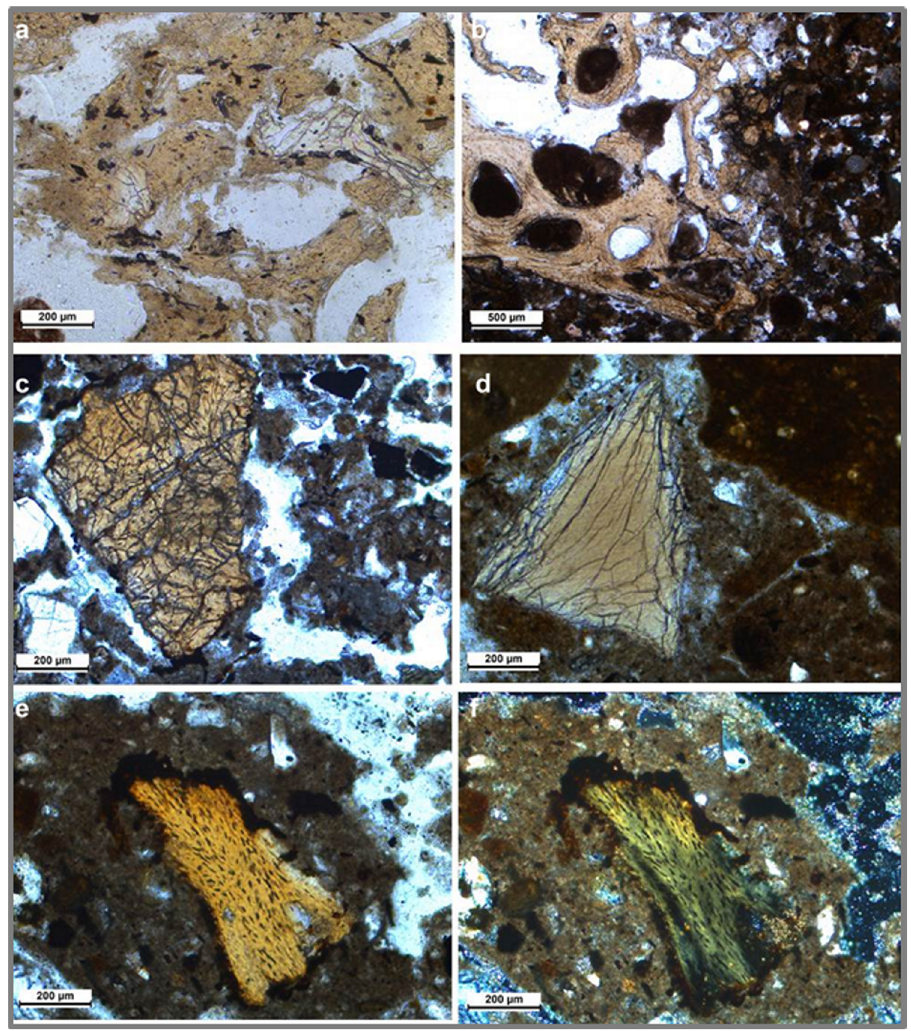
Figure 10: Micrographs from unit 8932 showing: ( a ) digested bone fragments within omnivore coprolite, ( b ) 4 cm fragment of bone showing loss of internal structure, weathering, and fragmentation at extremities, ( c ) and ( d ) highly weathered micro - scopic bone fragments, ( e ) bone fragment embedded within redeposited “ mortar ” fragment in PPL ( plane - polarized light ) and ( f ) XPL ( cross - polarized light )